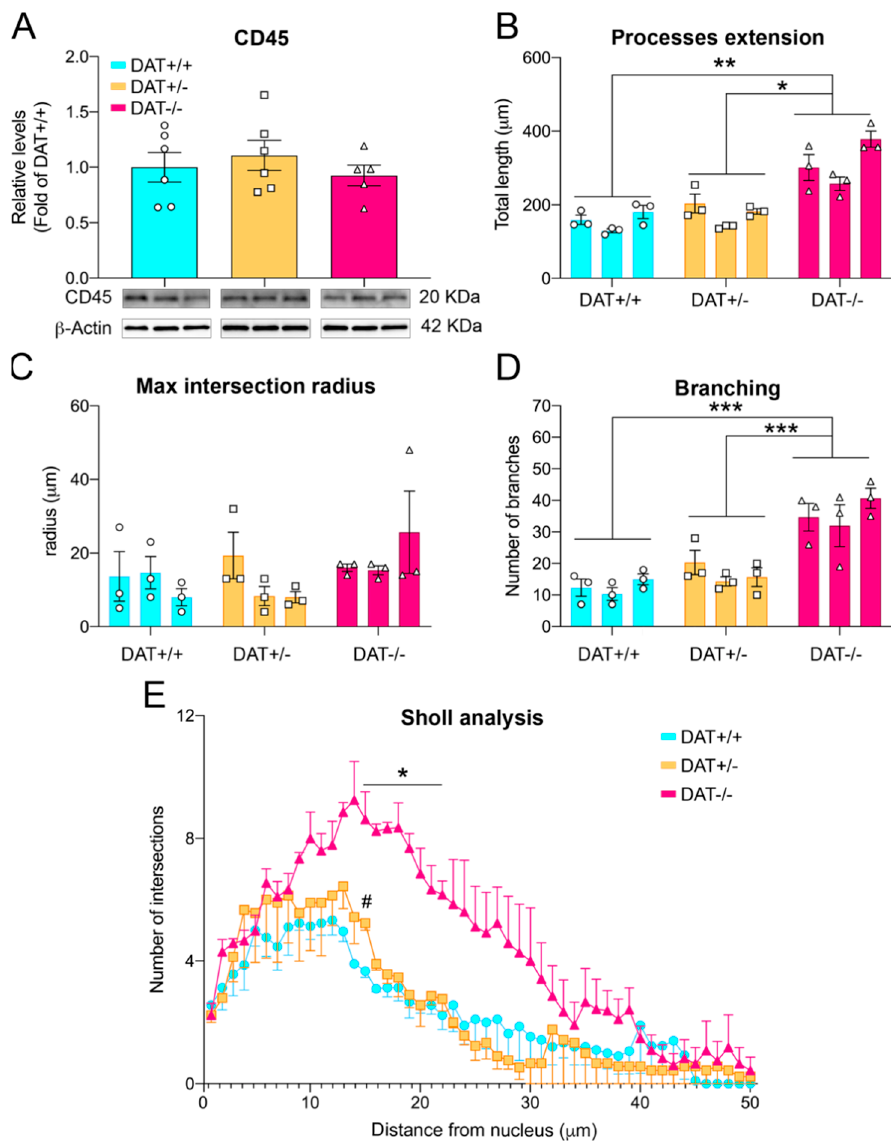
Figure 5. Pro-inflammatory phenotype of microglia in the PFC of DAT − / − rats. ( A ) Levels of CNS microglial marker CD45 were unchanged among the three genotypes. Morphometric analysis of Iba1 + cells showed ( B ) an increase in the total length extension of microglial processes of DAT − / − rats, ( C ) while mean maximum radius did not vary among genotypes. ( D ) Number of branches was significantly higher in DAT − / − rats. ( E ) Sholl analysis displayed higher number of intersections in Iba1 + cells in DAT − / − PFC. Individual data points are shown for each group. Data are presented as mean ± SEM, * p < 0.05, ** p < 0.001, *** p < 0.001.